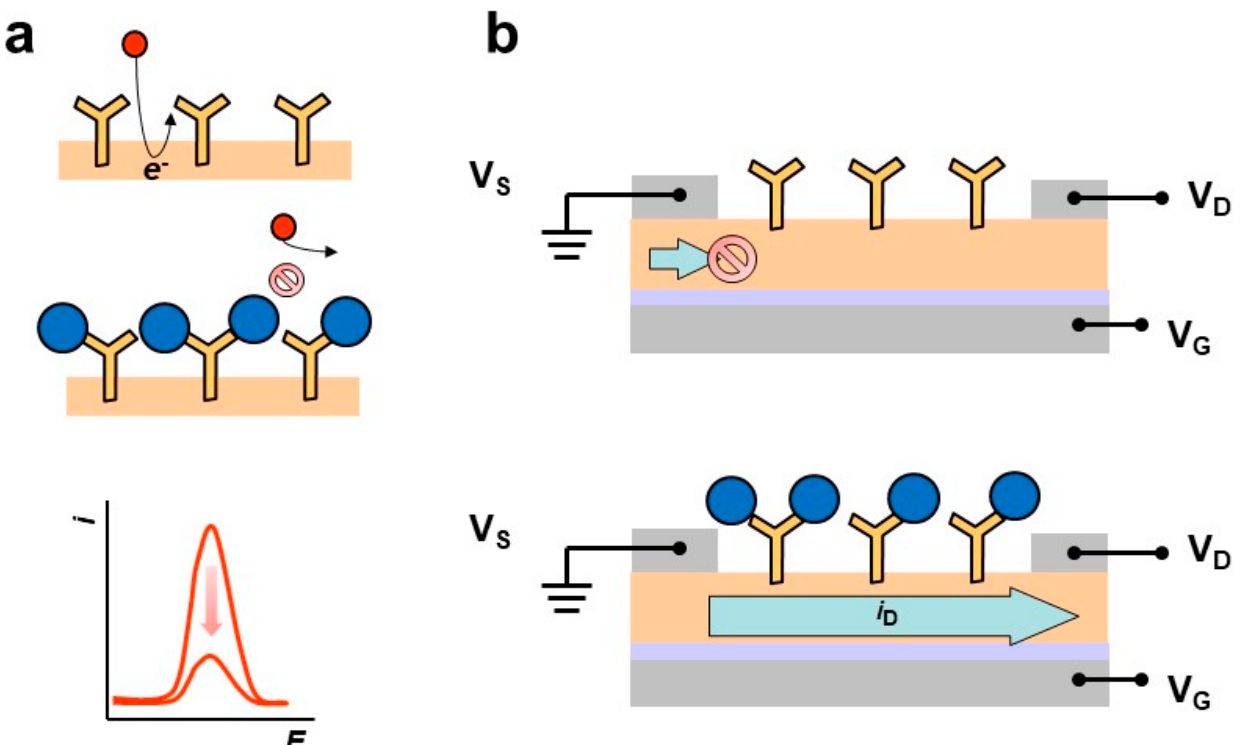
Figure 7. Schematic representation of two label-free immunosensors designs employed in sweat biosensors. ( a ) The formation of antibody-antigen (in yellow and blue, respectively) complexes can be detected indirectly since they block the electrode surface to the passage of a redox probe (red) and diminish current signals due to electron transfer reactions, a process that can be followed by voltammetric or impedimetric techniques (e.g., SWV, as shown in the figure). ( b ) Field-effect transistors allow for direct detection of the formation of antibody-antigen complexes (for instance, by measuring the drain current under appropriate conditions).